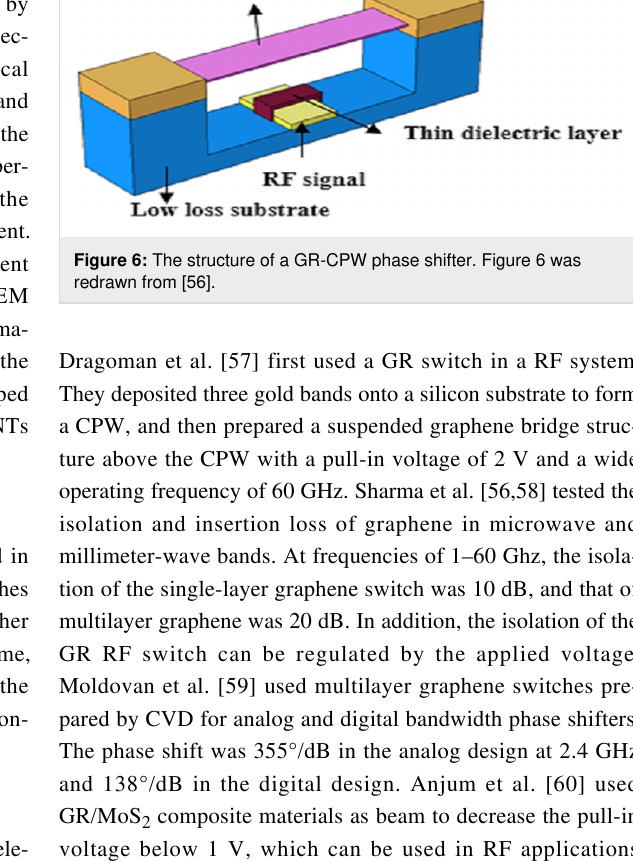
Dragoman et al. [57] first used a GR switch in a RF